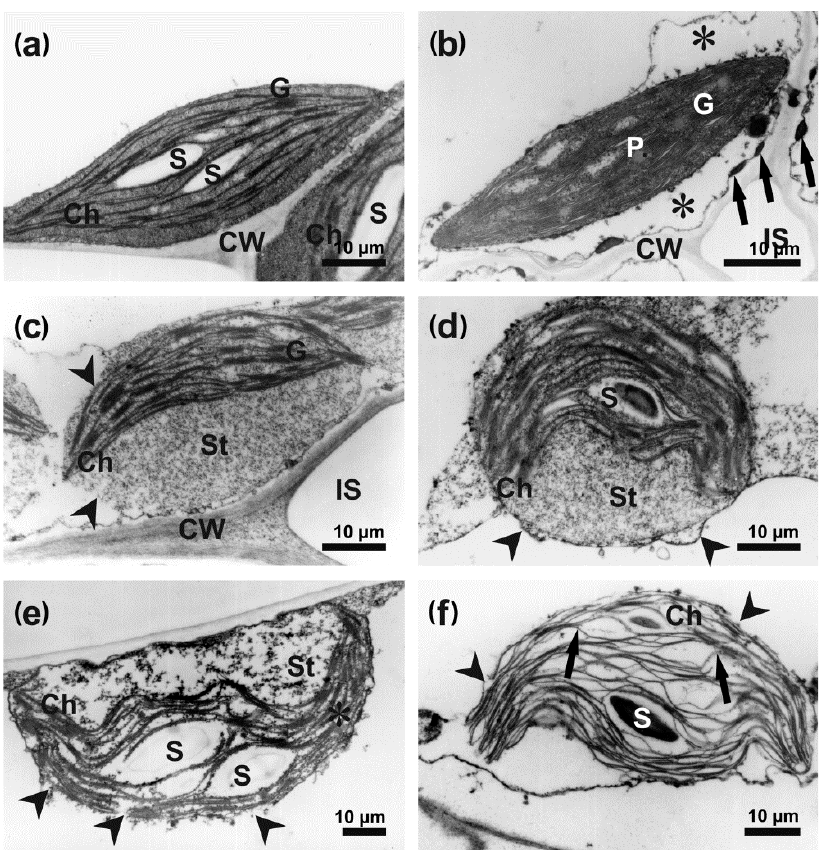
Figure 6. Disintegration of chloroplasts in B. oleracea leaf mesophyll cells infected with A. brassicicola at 48 hpi. The images were captured using TEM. ( a ) lenticular-shaped chloroplast with typical thylakoid and grana structure, and small starch grains in uninfected leaf; ( b ) fragment of mesophyll cell with degraded cytoplasm (asterisks), osmiophilic granules in plasmalemma (arrows) and a typical well-preserved chloroplast with plastoglobuli; ( c ) round-shaped chloroplast with a still preserved thylakoid and grana system, disintegrated chloroplast envelope (arrowheads) and swollen electron-translucent stroma; ( d ) round-shaped chloroplast with cup-shaped thylakoid system, reduced number of grana, locally swollen envelope (arrowheads) and electron-translucent stroma; ( e ) strongly disintegrated chloroplast with flocculent remnants of stroma, locally disintegrated envelope (arrowheads) and collapsed thylakoid system (asterisks) devoid of grana; ( f ) remnants of chloroplast with destroyed envelope (arrowheads) and thylakoids with widened lumens (arrows). Grana and stroma are missing. Abbreviations: Ch—chloroplast, CW—cell wall, G—granum, P—plastoglobule, S—starch grain,